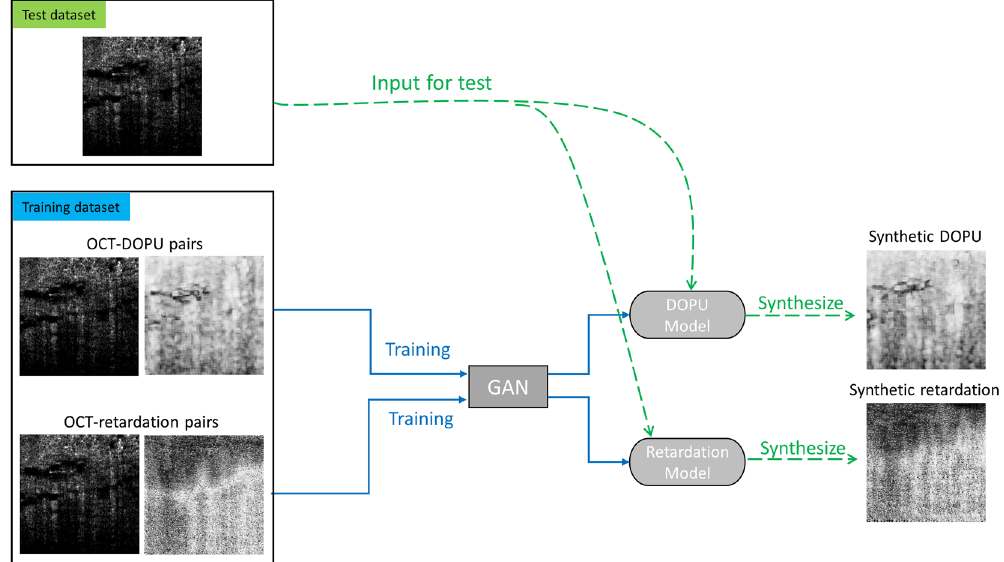
Fig. 1 Work fl ow of computational PS-OCT imaging. Two models were separately trained to synthesize DOPU and phase retardation contrasts with OCT intensity images as the input.